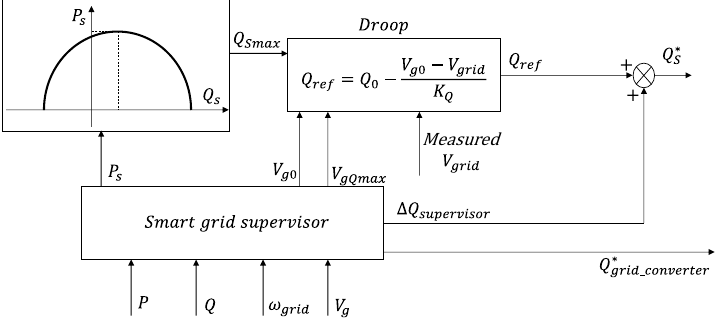
Figure 11. Diagram for generating the reactive power references of the stator and the GSC converter.